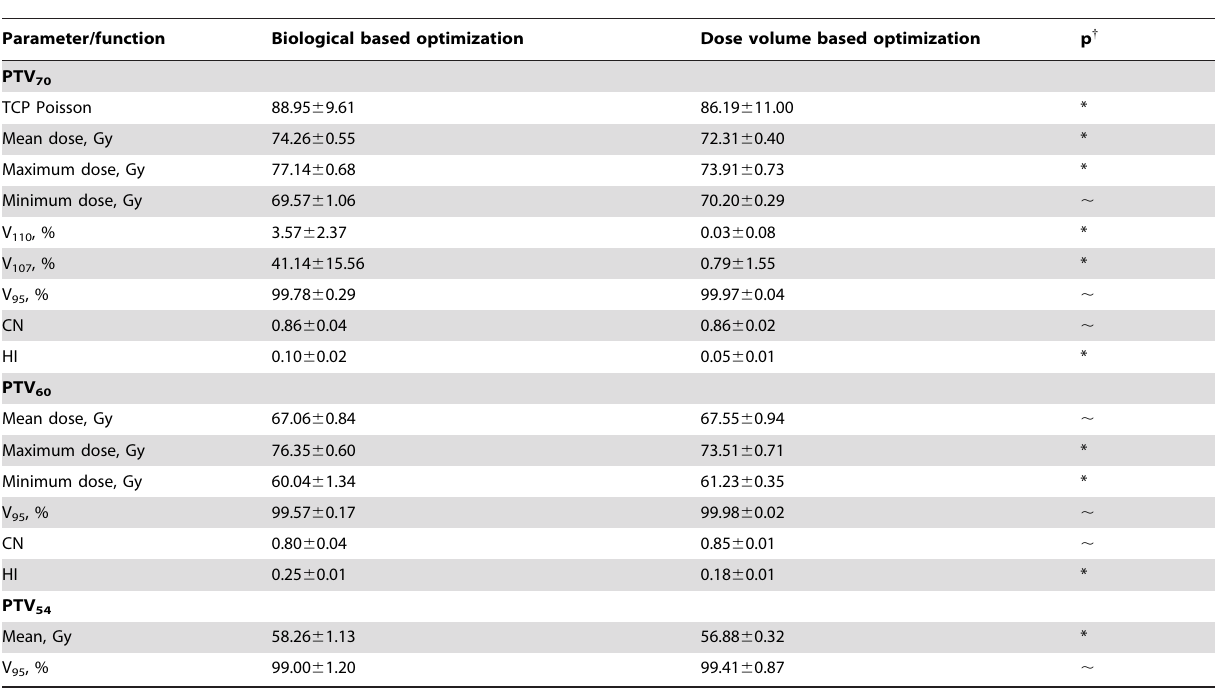
Table 5. Summary of biological and physical evaluation results for targets averaged over 10 advanced stage NPC